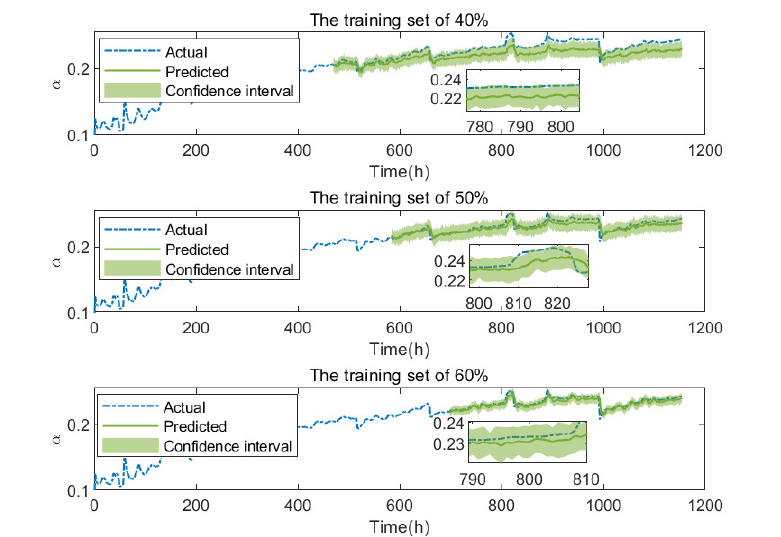
Figure 6. The degradation prediction of FC1 with different training set sizes.